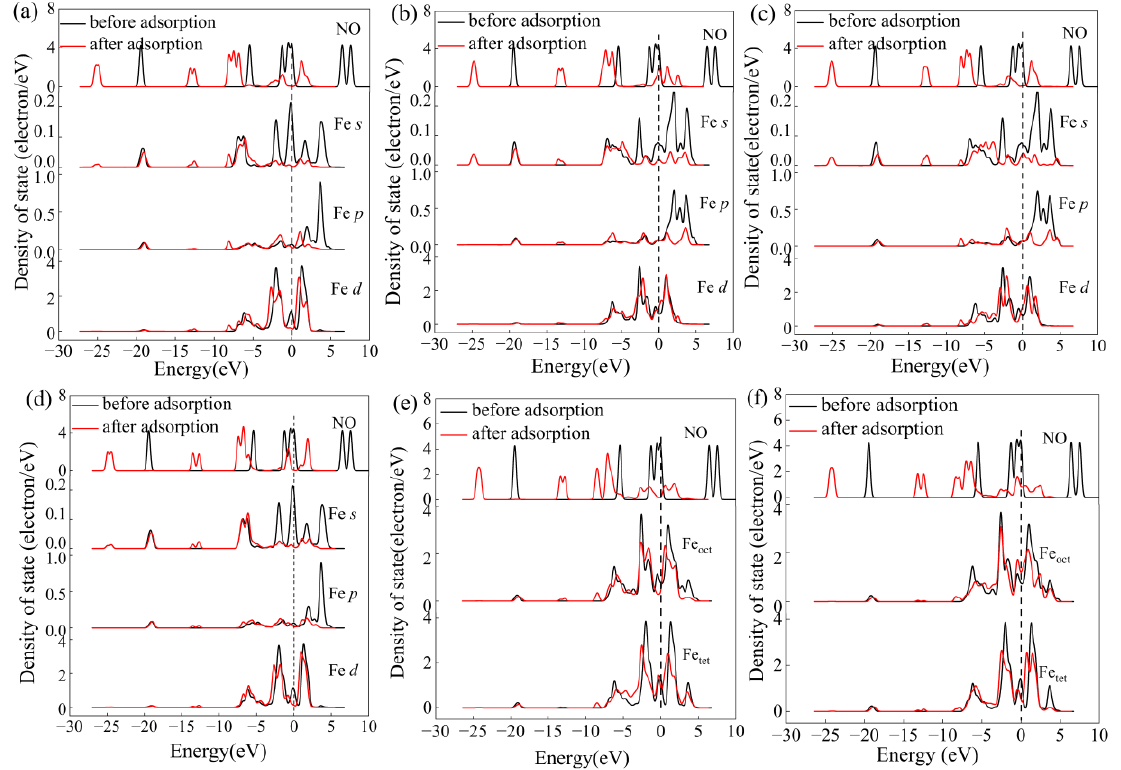
Figure 4. The PDOS for the system before and after NO adsorption onto the γ -Fe 2 O 3 (111) surface. PDOS of configuration 1A (a), PDOS of configuration 1B (b), PDOS of configuration 1C (c), PDOS of configuration 1D (d), PDOS of configuration 1E (e), PDOS of configuration 1F (f).